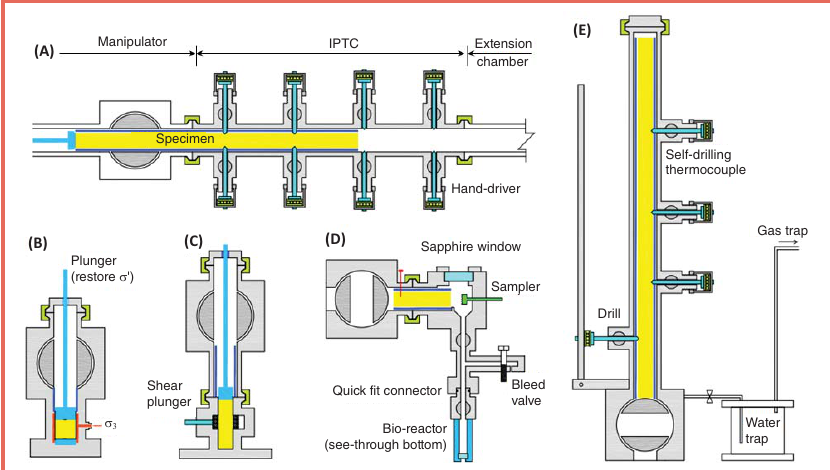
Figure 2. Schematic diagrams of characterization chambers. [A] IPTC with P-T control. [B] ESC with (cid:4) ’-P-T control. [C] direct shear chamber (DSC) with (cid:4) ’- (cid:5) -P-T control. [D] sampler for multiple bio-reactor chambers (BIO). The outside diameter of the large ball valve shown in all devices is 220 mm. [E] controlled depressurization chamber (CDC) for sediment preservation and gas